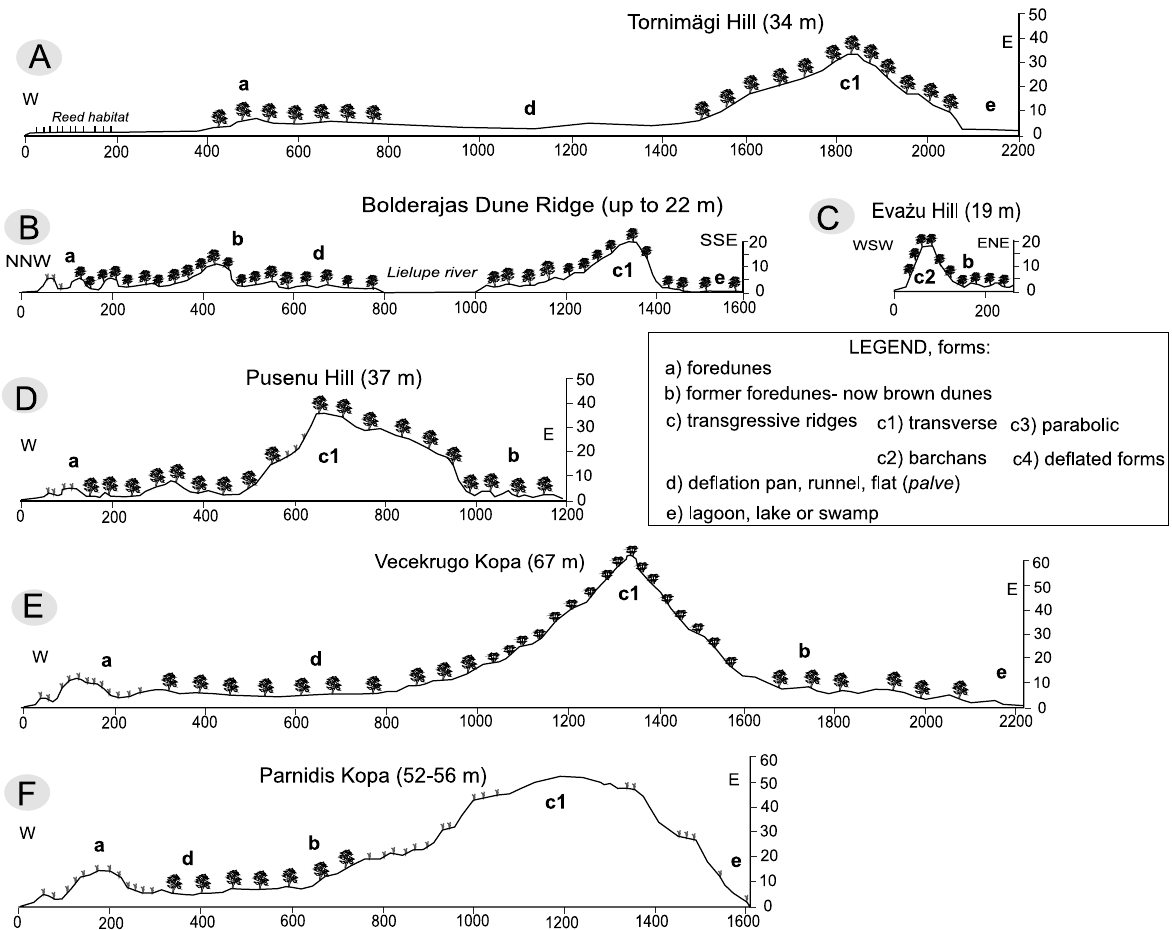
Fig. 10. The examples of highest and largest transverse dunes in each section of Baltic Sea coast (height in m a.s.l., distance in m), location on Fig. 1 ( Łabuz